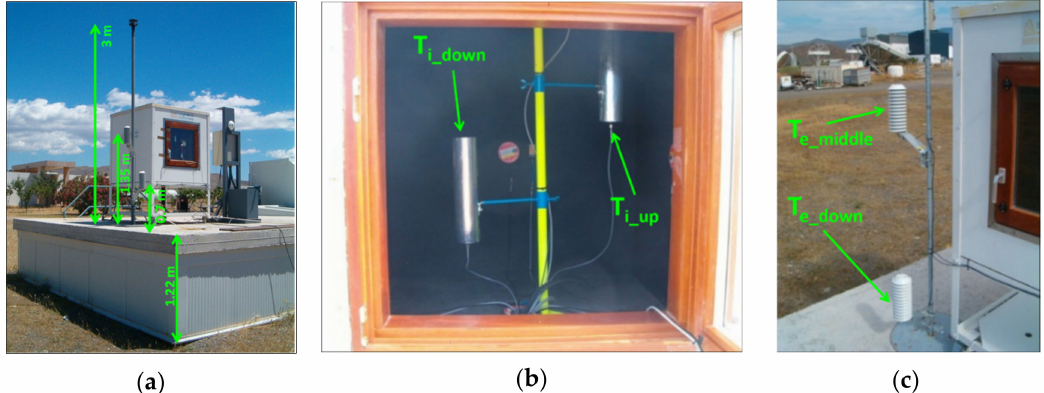
Figure 1. Experiment set up. ( a ) Test box and measurement devices in its surroundings, ( b ) detail of installation of indoor air temperature sensors protected by aluminum cylinders, ( c ) detail of installation of shielded and ventilated outdoor air temperature